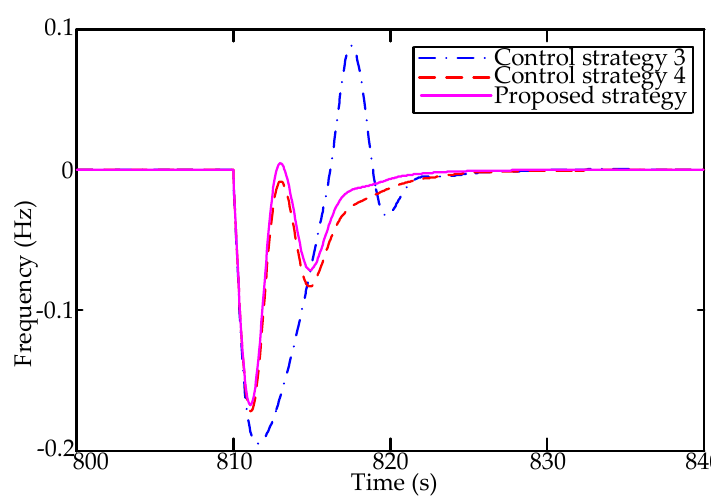
Figure 9. The frequency response under different allocation strategies.